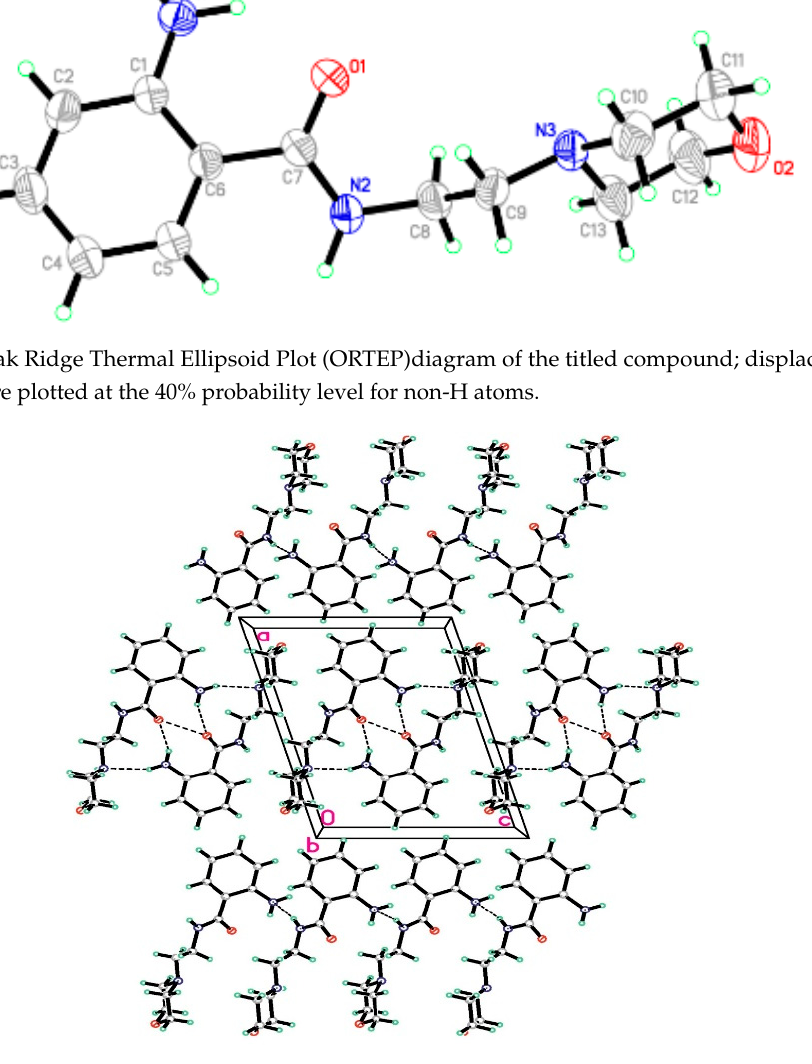
Figure 3. Molecular packing of the titled compound displaying hydrogen bonds, which are drawn as dashed lines along the c -axis.